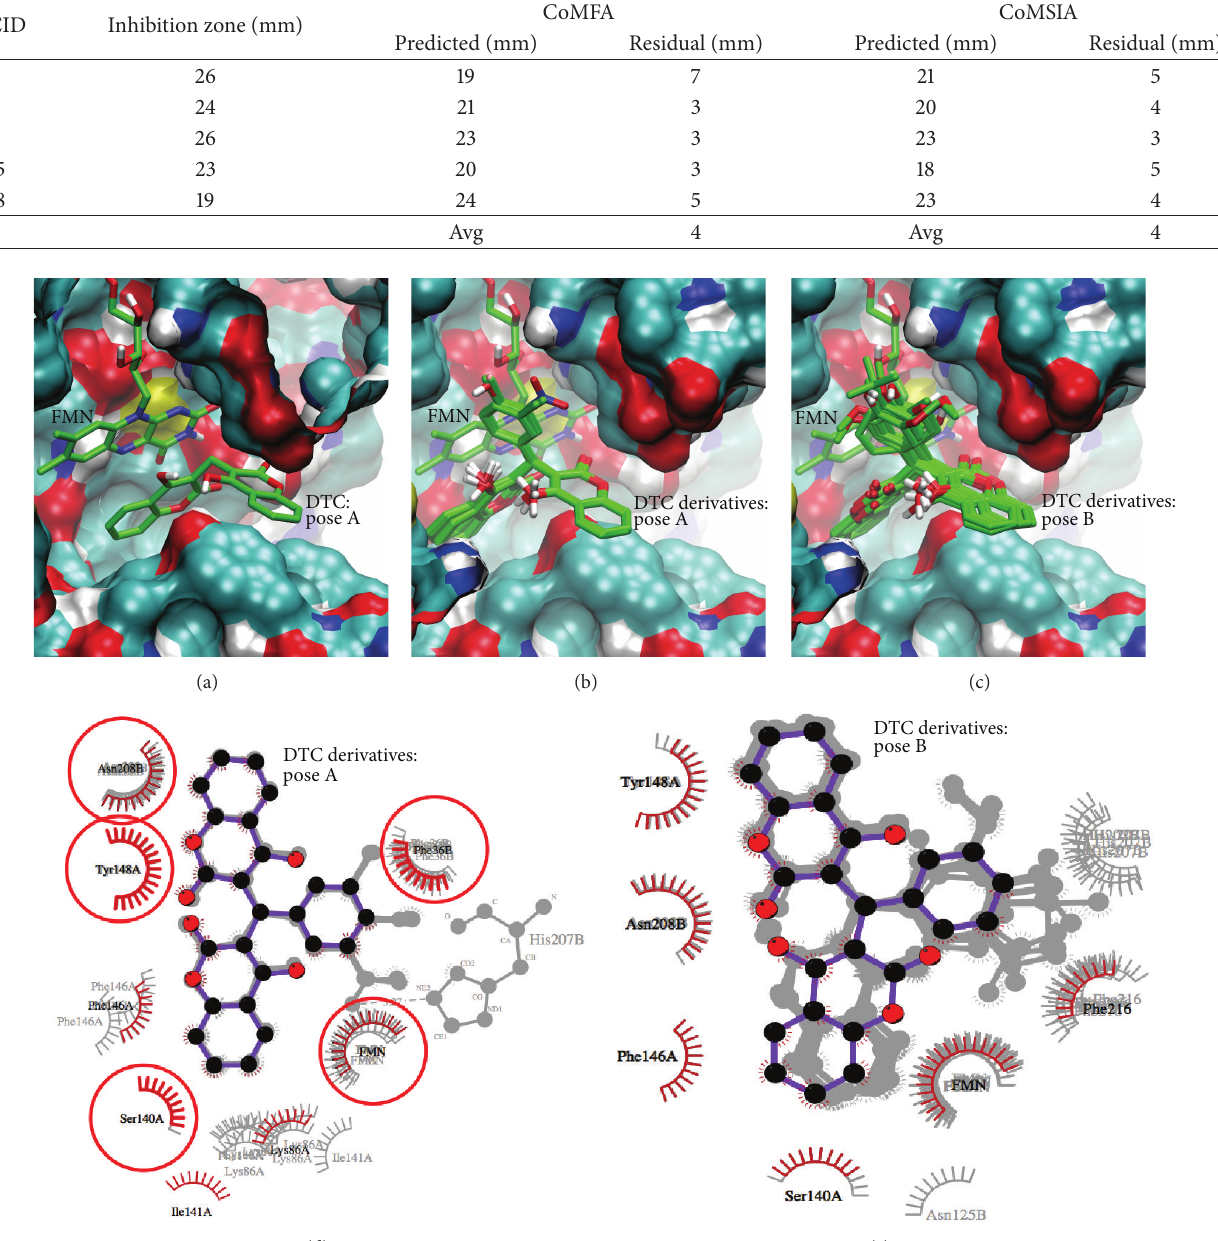
Table 4: Experimental and predicted activities of test set compounds.